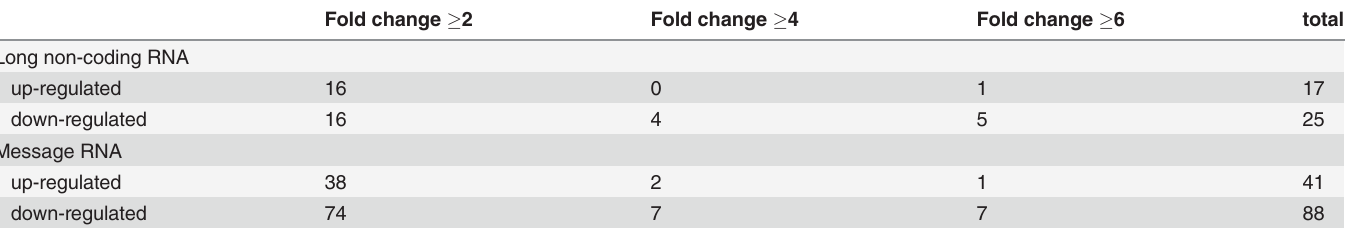
Table 3. Relative differential lncRNA and mRNA expression in the kidneys between low birth weight and control rats at postnatal day 10 of life, de- tected using microarray. Fold change (cid:1) 2 Fold change (cid:1)